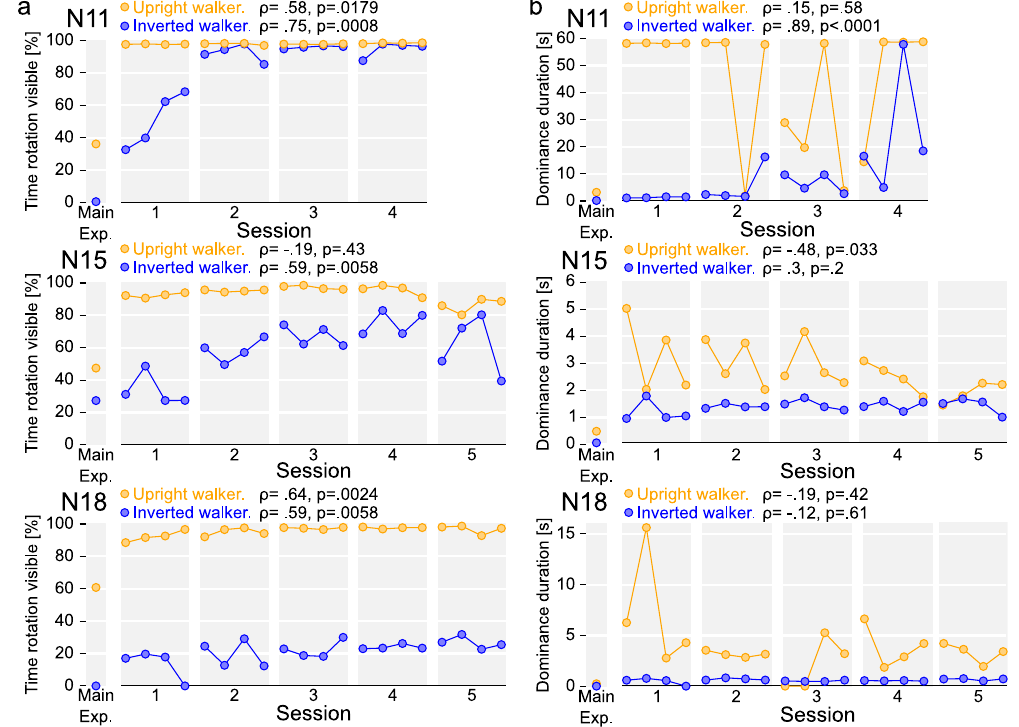
Figure 2. Results of Learning experiment. Values in the legend are Spearman’s rank correlation between a plot’s variable and time (running block index across all sessions). ( a ) The fraction of the time when observers reported the perception of rotation. ( b ) Average perceptual dominance duration (geometrical